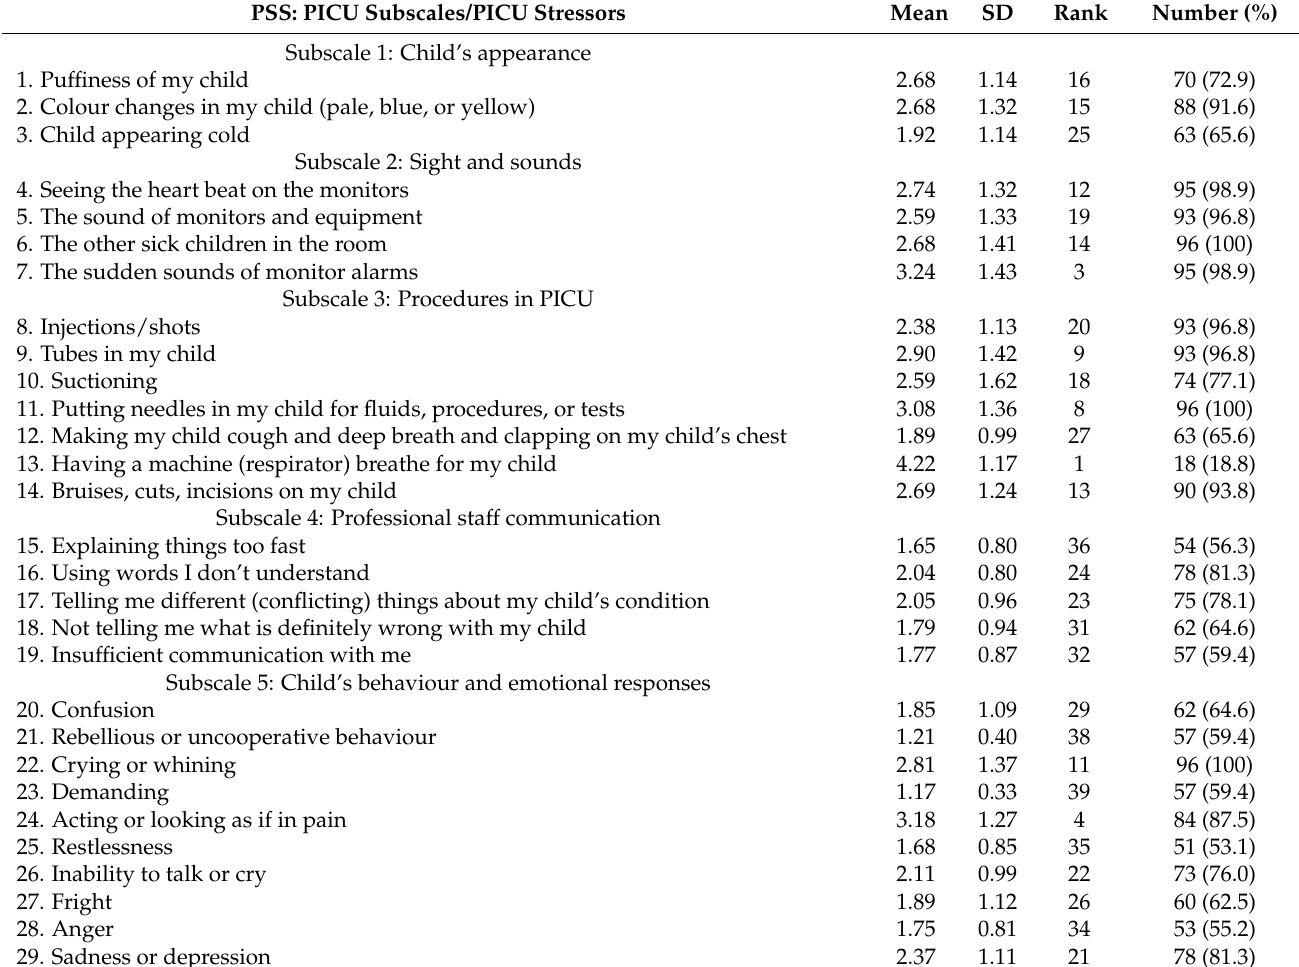
Table 3. Exposure and level of perceived stress of parents according to PSS: PICU